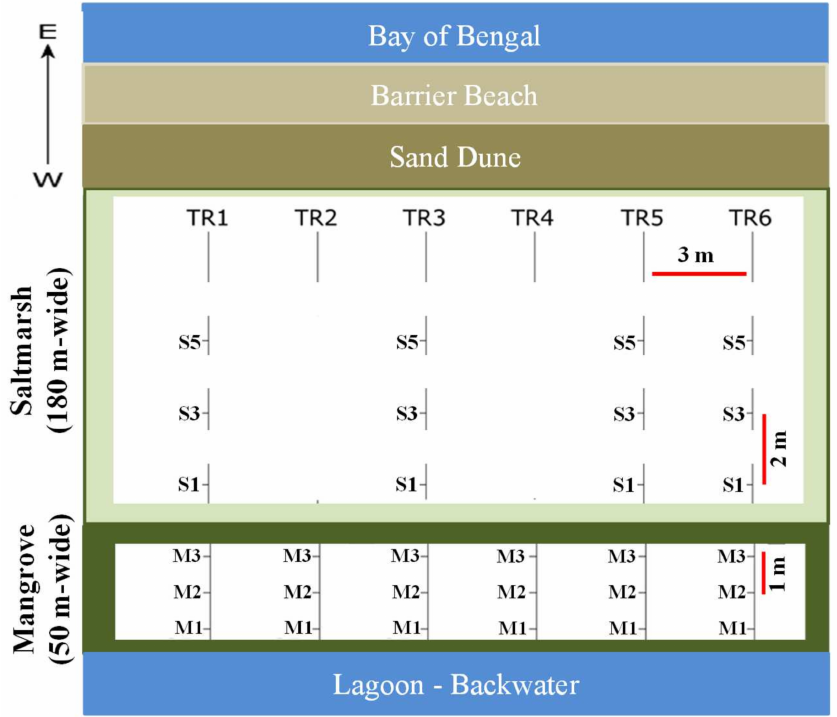
Figure 2. Schematic illustration of sampling stations. TR: transects (1–6). M: mangrove stations. S: saltmarsh